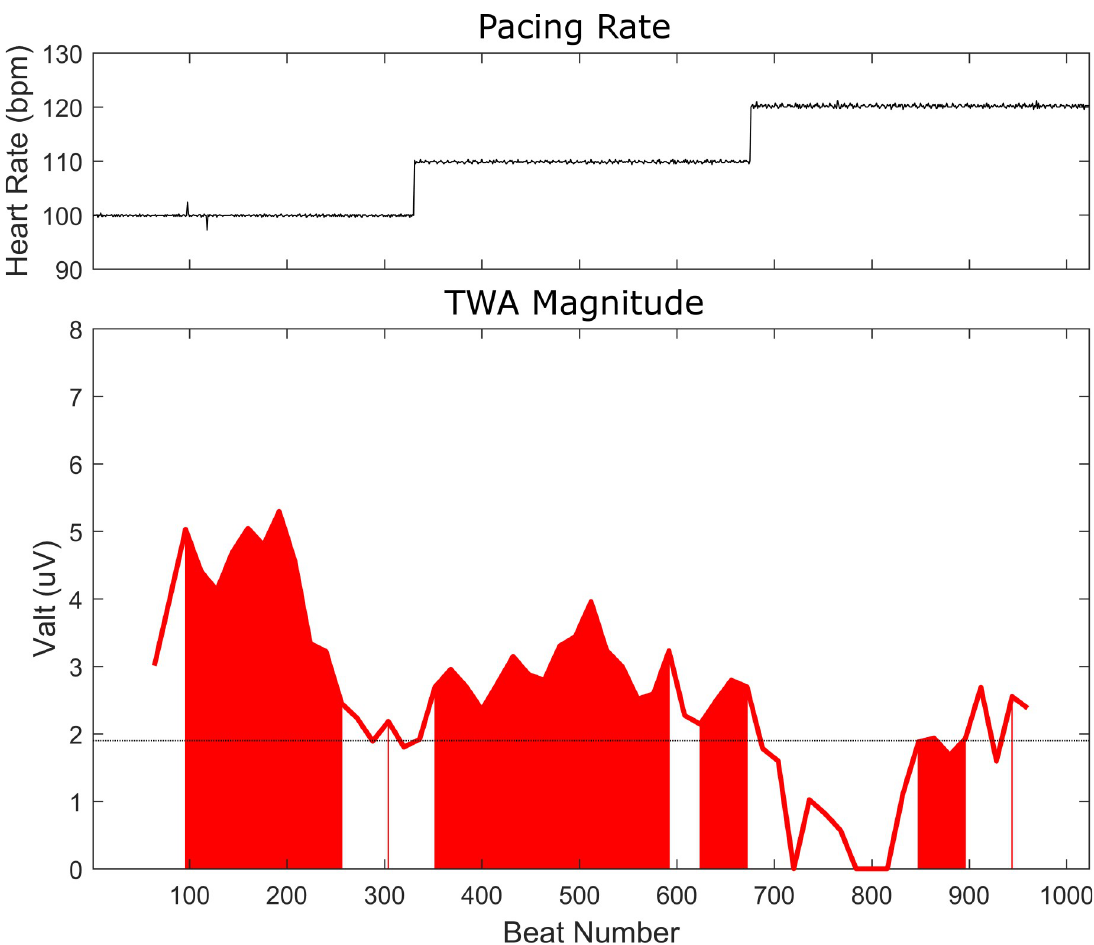
Fig 7. Illustration of TWA magnitude attenuation (lower panel) associated with increasing atrioventricular pacing rate (upper panel) in a precordial lead of a representative patient. The TWA magnitude decreases by ~1.5 uV with each subsequent 10 bpm increase in rate, causing TWA magnitude to fall below clinical significance at 120 bpm. The red shaded regions indicate V alt values with a k � 3. The dotted black line denotes the clinical TWA V alt cutpoint of 1.9 uV.